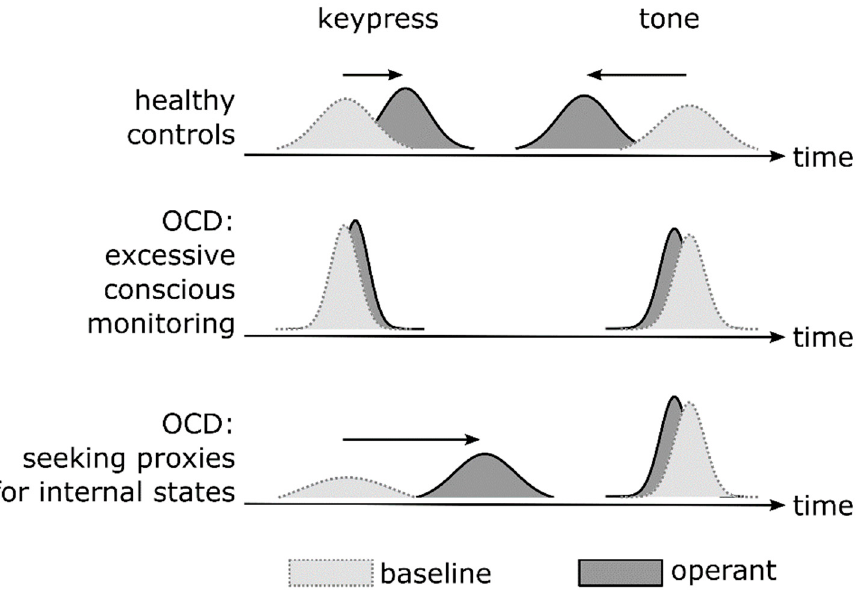
Figure 2. Intentional binding in healthy individuals ( top ) and patients with OCD, under the assumption of excessive conscious monitoring of action ( middle row ) and the “seeking proxies for internal states” (SPIS) model ( bottom row ). Arrows indicate changes in perceived timing from baseline (light grey) to operant conditions (dark grey).